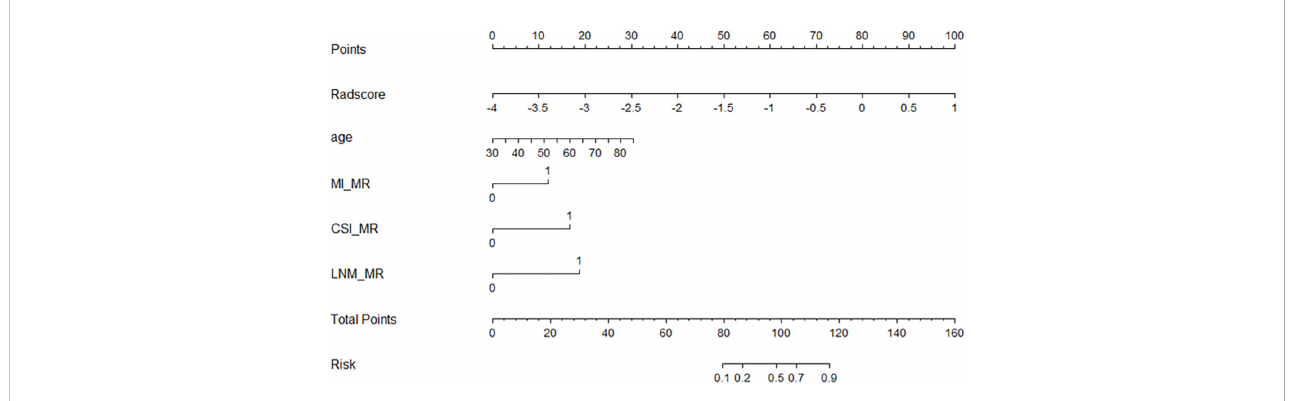
FIGURE 4 Nomogram for predicting the tumor grade of endometrial cancer, established based on multiparameter magnetic resonance imaging and patient age.